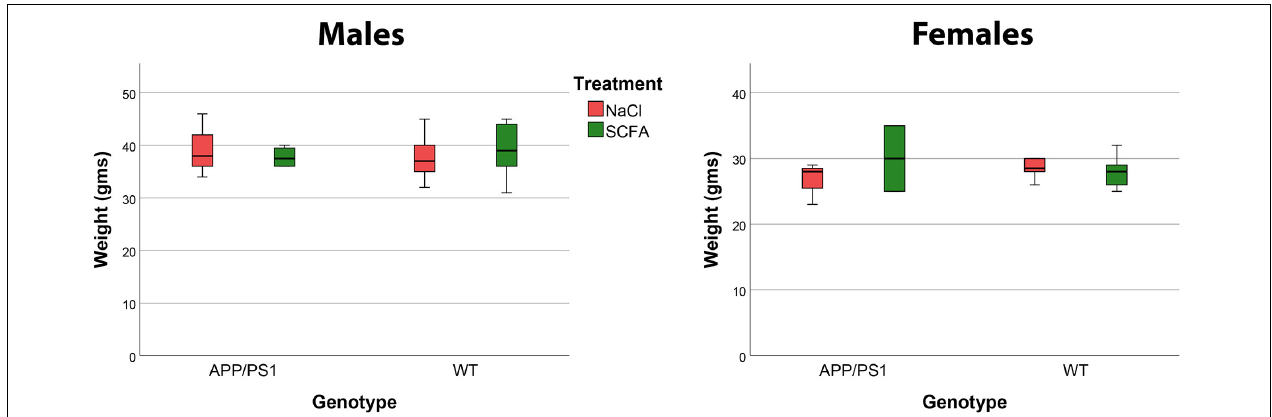
FIGURE 1 | Mouse body weights were not affected by short chain fatty acid (SCFA) supplementation. Male mice weighed significantly more than female mice ( p < 0.0001), but body weight was not influenced by SCFA-supplemented drinking water (A) or by the presence of the APP/PS1 transgenes (B) ( p > 0.05). These data reflect weights on the day of